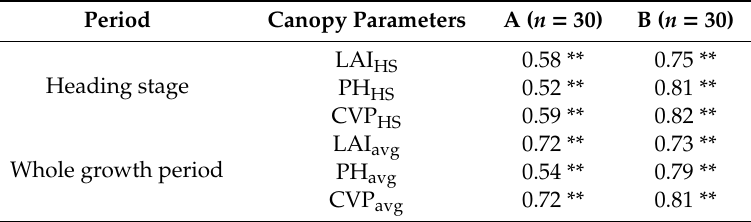
Table 3. Correlation analysis results of canopy parameters and yield.